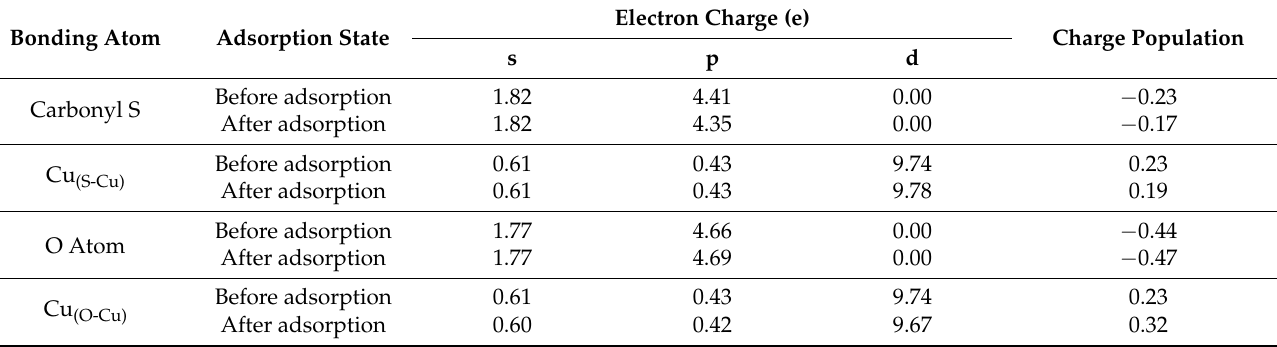
Table 11. Mulliken charge populations of bonding atoms before and after